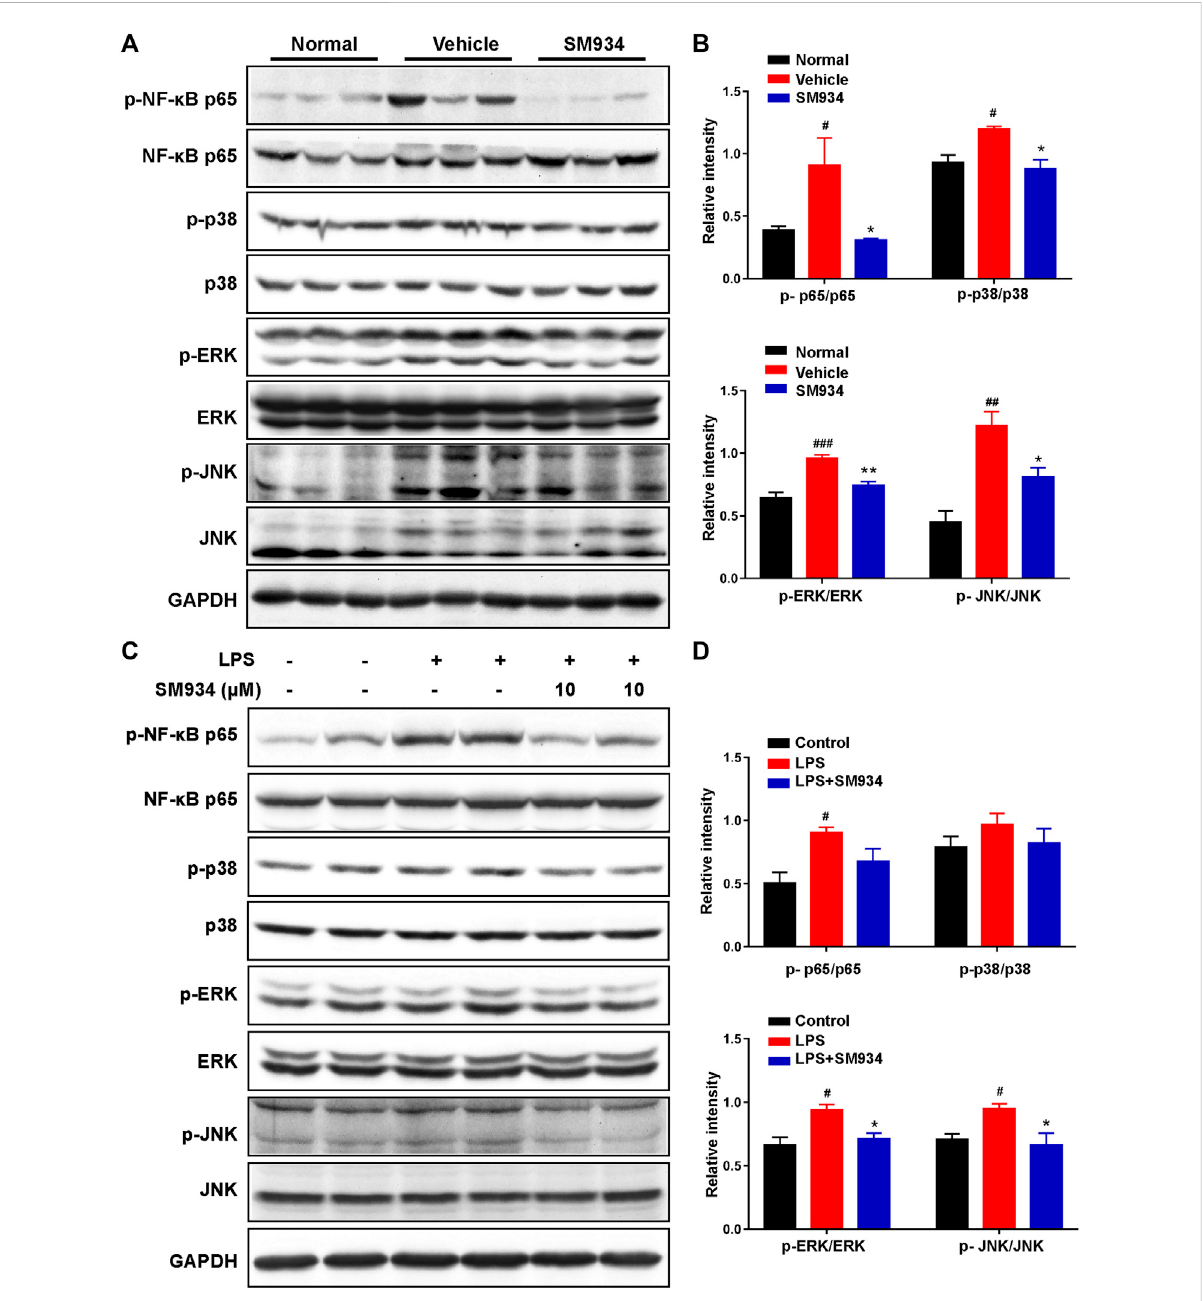
FIGURE 7 SM934 suppressed the activation of NF- κ B and MAPK signaling pathways both in vivo and in vitro . (A) Phosphorylation of NF- κ B, p38, ERK, and JNK in colon tissues was detected with a Western blot. (B) Relative intensities of the phosphorylation levels of NF- κ B, p38, ERK, and JNK as normalized against total proteins. (C) HT-29 cells were stimulated with LPS (1 μ g/ml) for 24 h without or with SM934 (cells pro-cultured with SM934 for 1 h); then, cells were harvested for NF- κ B, p38, ERK, and JNK signals tested with Western blot. (D) Relative intensities of the phosphorylation levels of NF- κ B, p38, ERK, and JNK as normalized against total proteins in vitro . Data are shown as means ± SEM. # p < 0.05, ## p < 0.01, and ### p < 0.001 vs . control group; * p < 0.05 and ** p < 0.01 vs . LPS